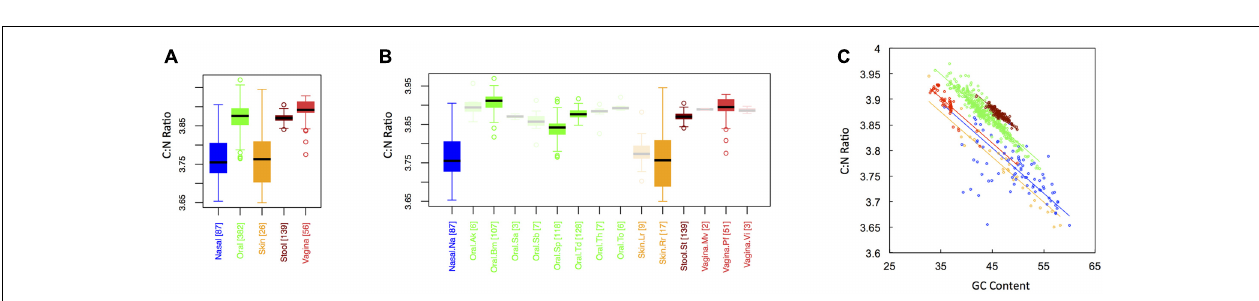
FIGURE 4 | Boxplots showing the average sulfur content of microbial proteins as a function of human body site for (A) the 5 major sites and (B) the 15 minor sites in our study. The number of samples from each site is indicated in square brackets on axis labels. Faded boxes are used for sites with fewer than 10 samples. Differences in sulfur content were tested with Dunn’s test. Statistics are summarized in Appendix II, Tables A.2.10, A.2.11; (C) Scatterplot of sulfur content versus GC content with associated regression lines from our ANCOVA analysis for major body sites: nasal (blue), oral (green), skin (yellow), stool (brown), and vaginal (red).